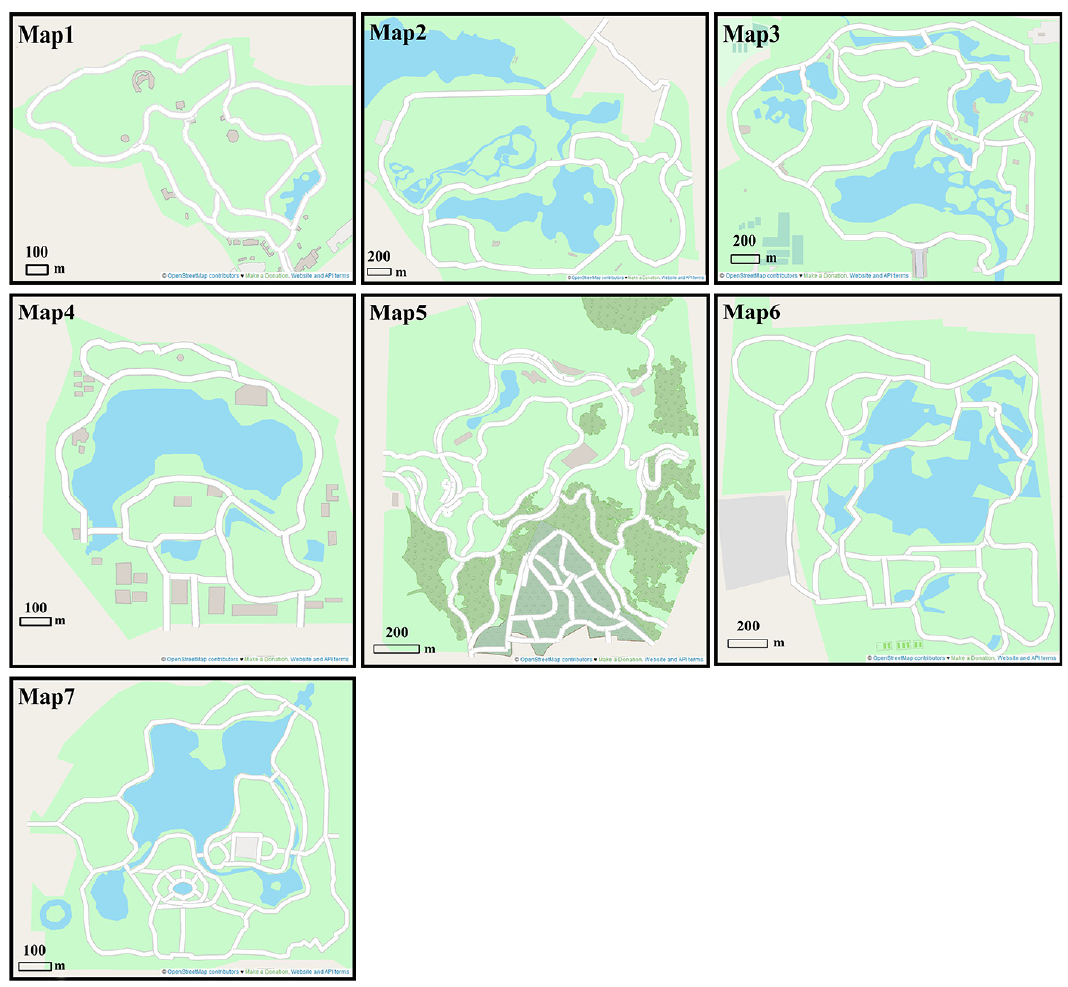
Figure 2. The seven baseline maps used in this